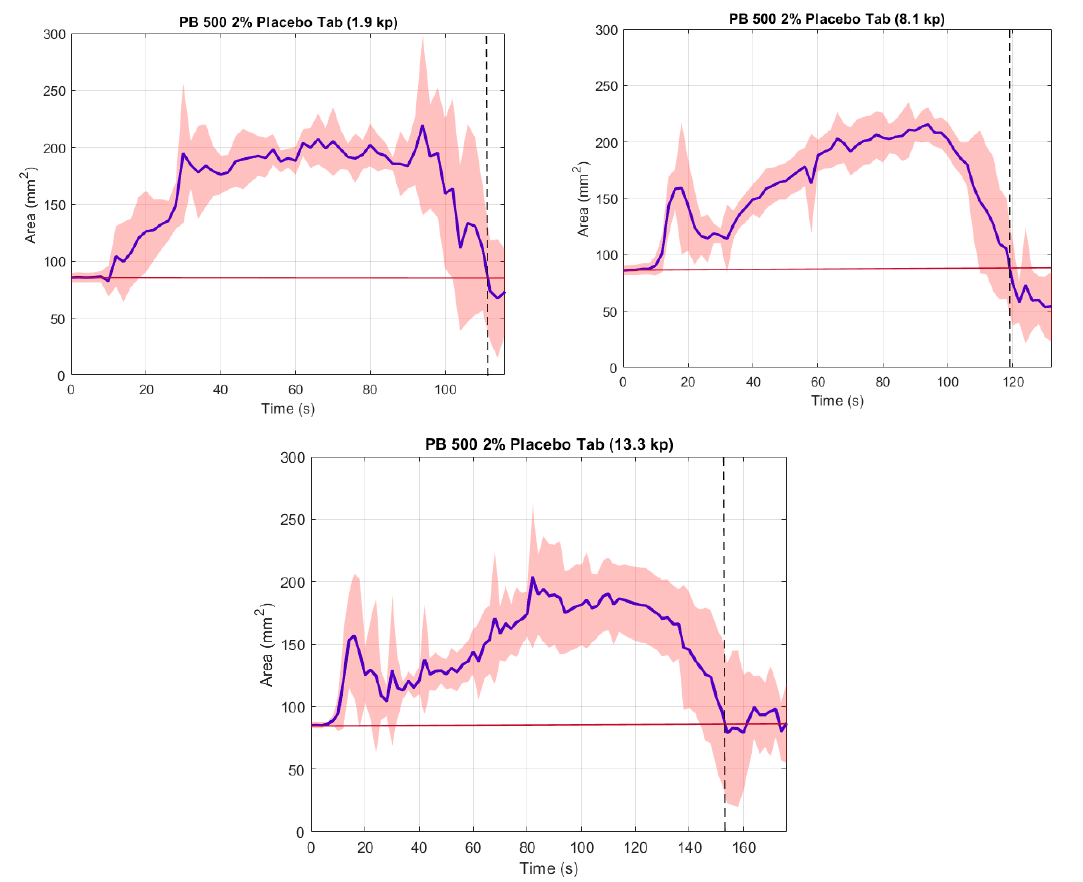
Figure 4. Mean top-down area-time profiles for ODTs assessed in the oral cavity model (OCM) ( n =